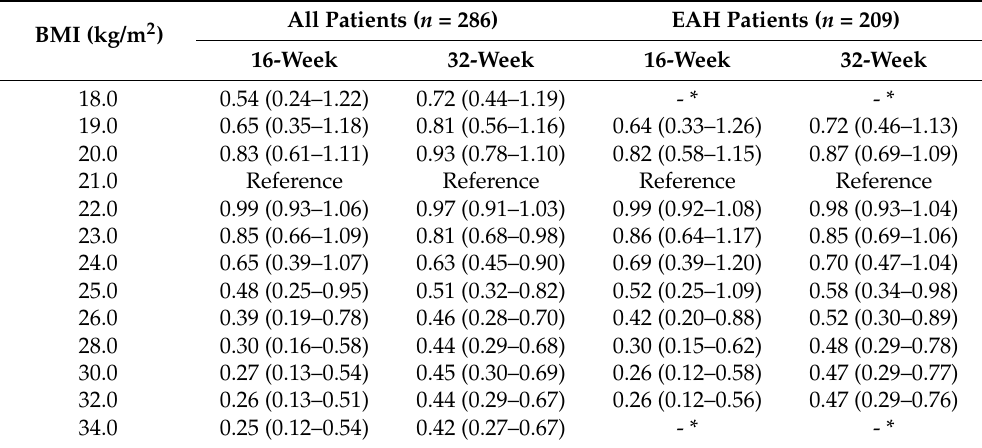
Table A1. Non-linear analysis between BMI and cumulative CR